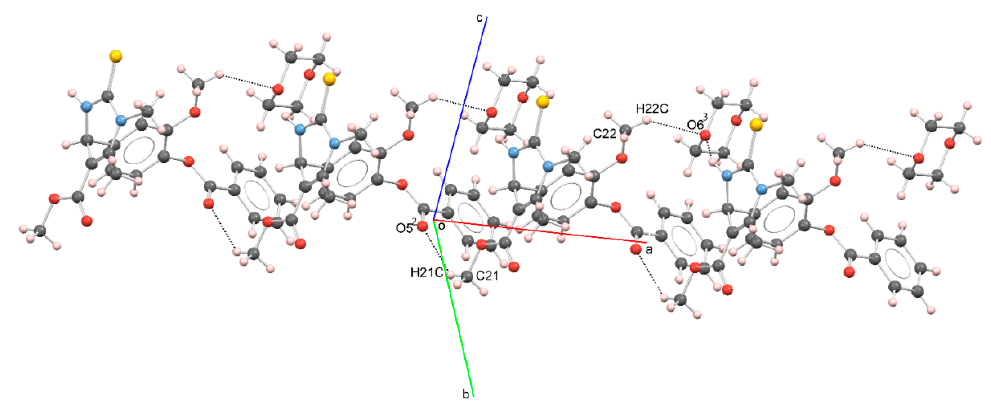
Figure 3. MERCURY [29] drawing of crystal packing of 4-(4 ′ -benzoyloxy-3 ′ -methoxyphenyl)- 1,2,3,4-tetrahydro-1,6-dimethyl-2-thioxopyrimidine-5-carboxylate ( 4j ) showing intermolecular C—H ••• O contacts (dashed line) connecting molecules in a head-to-tail manner along the a axis. Symmetry codes: 2 : x − 1, y, z ; 3 : x+1, y, z .